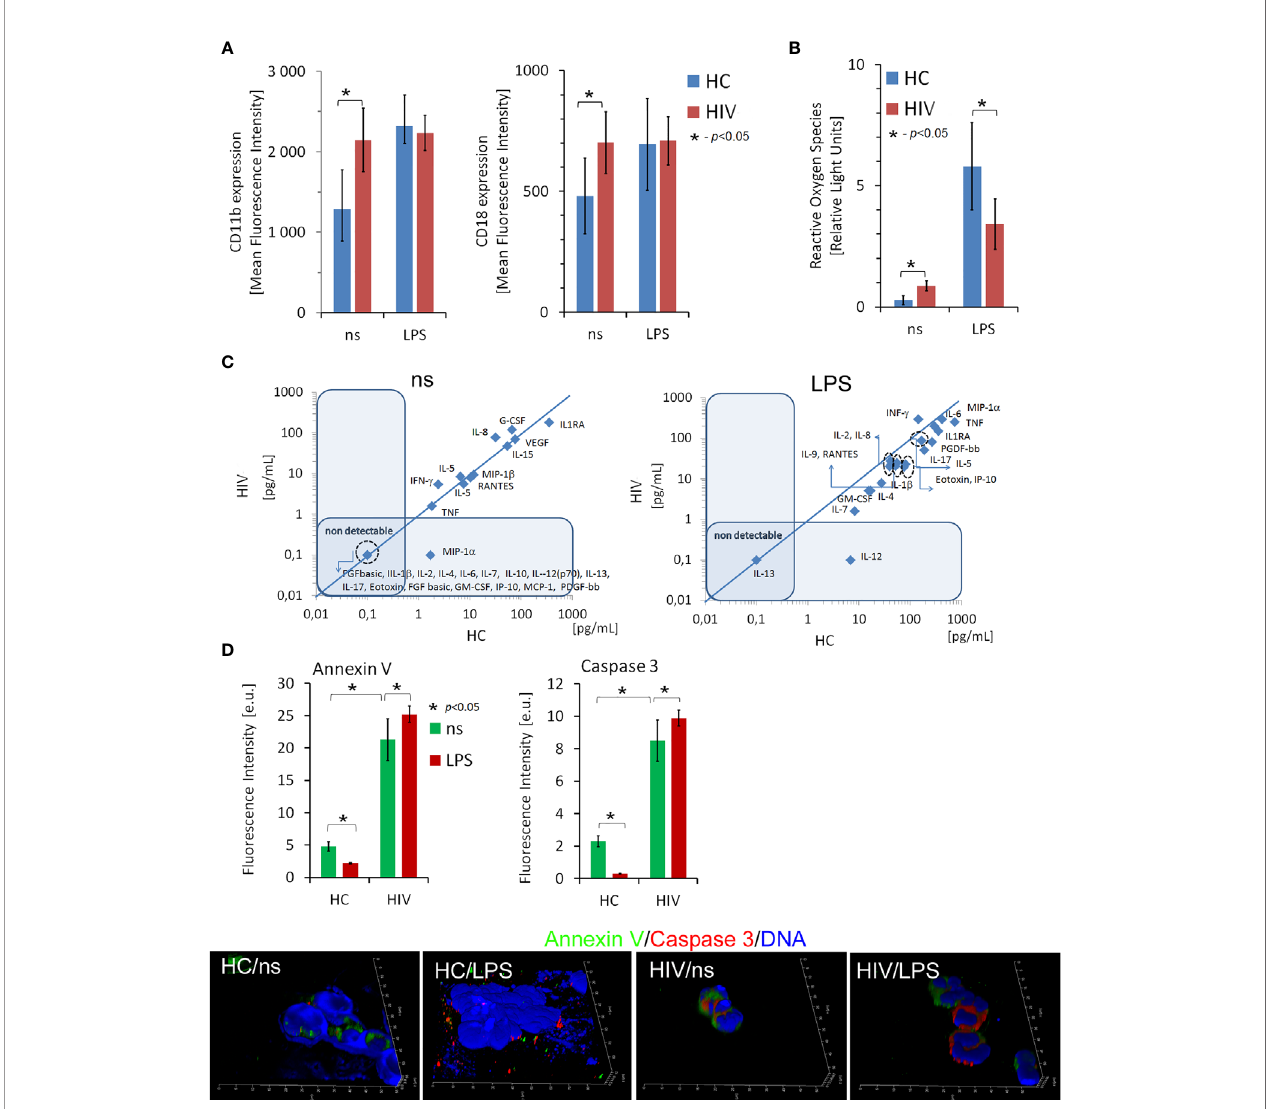
FIGURE 1 | Dysfunction of non-stimulated and LPS-stimulated HIV neutrophils. (A) Expression of CD11b and CD18 adhesion molecules on the surface of neutrophils in HIV vs. HCs. The bars represent the mean of fl uorescence intensity ± SD (B) Reactive oxygen species production by non- and LPS-stimulated neutrophils. The bars represent the mean of ROS production in Relative Fold Units ± SD. (C) The comparison of the pro fi le of cytokine/chemokine/growth factors released by non-stimulated (left panel) and LPS-stimulated (right panel) neutrophils. The blue line determines the border between up- and down-regulated factors. (D) ICC double labeling for caspase-3 (red pseudocolor) and annexin-V (green) revealed that circulating HIV neutrophils are apoptotic. Additional LPS stimulation does not inhibit neutrophil apoptosis as it takes place in HC neutrophils. Nonspeci fi c fl uorescence (signal noise) was electronically diminished to the level when nonspeci fi c signal was undetectable (background). The bars represent average fl uorescence intensity ± SD calculated from four patients, using at least 100 single cells for each